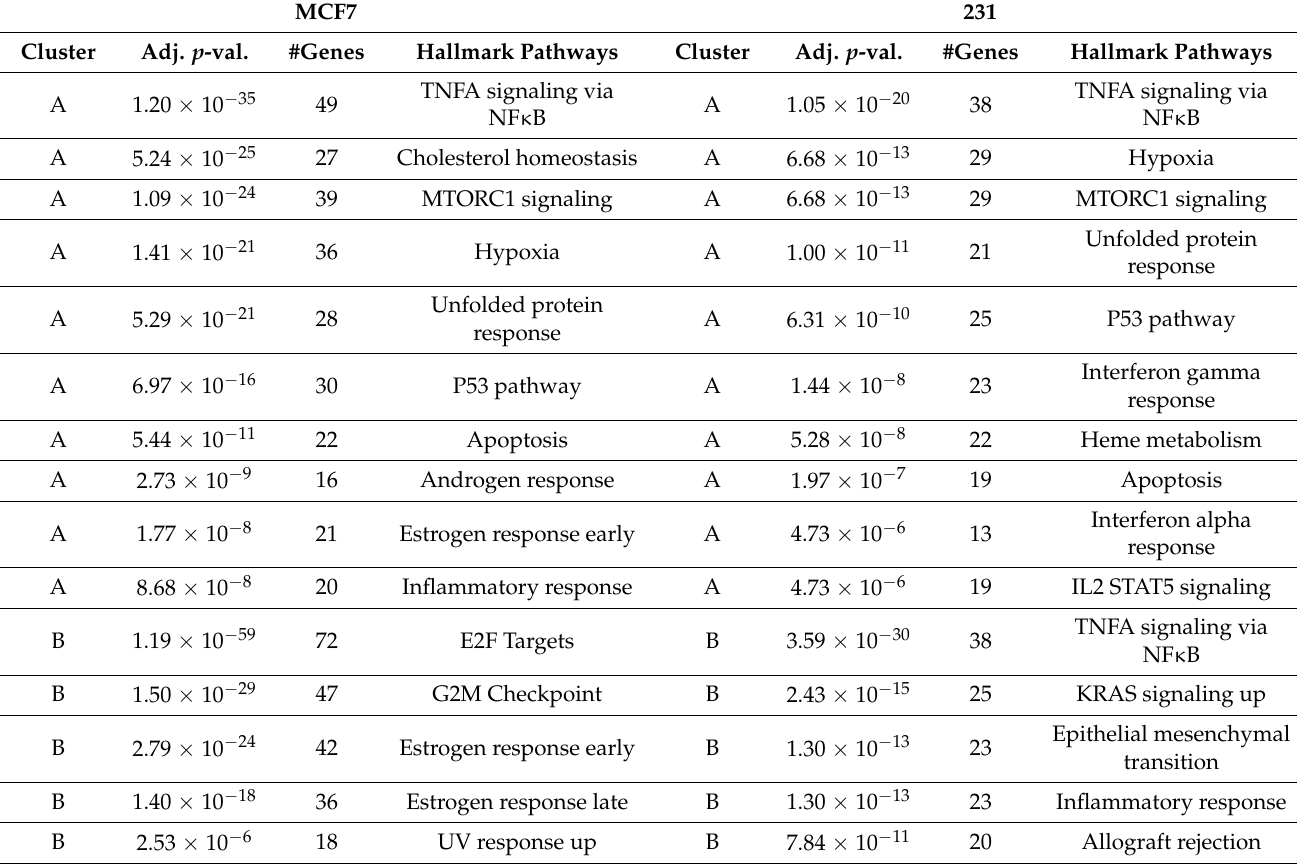
5.24 × 10 − 25 27 Cholesterol